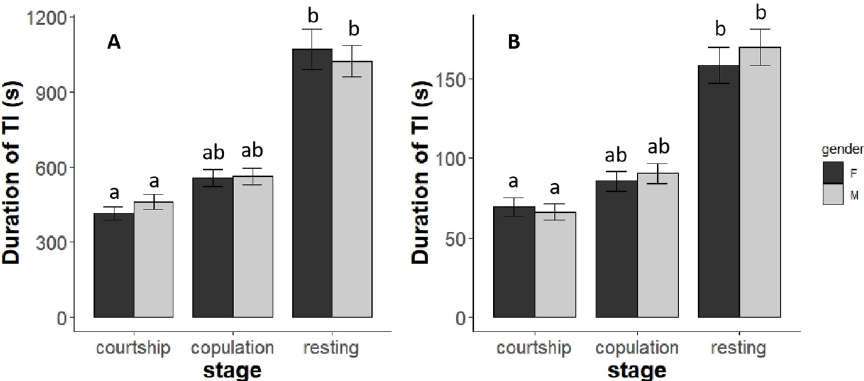
Figure 4. The duration of TI of 3 stages of female and male SPWs from L-strain and S-strain: ( A ) SPWs from L-strain. ( B ) SPWs from S-strain. Treatments with different letters are significantly different ( p < 0.05) in a generalized linear model. Error Standard errors are shown on the column bars. In experiment 2, strains significantly affected the frequency ( χ 2 = 13.23, p < 0.01) and